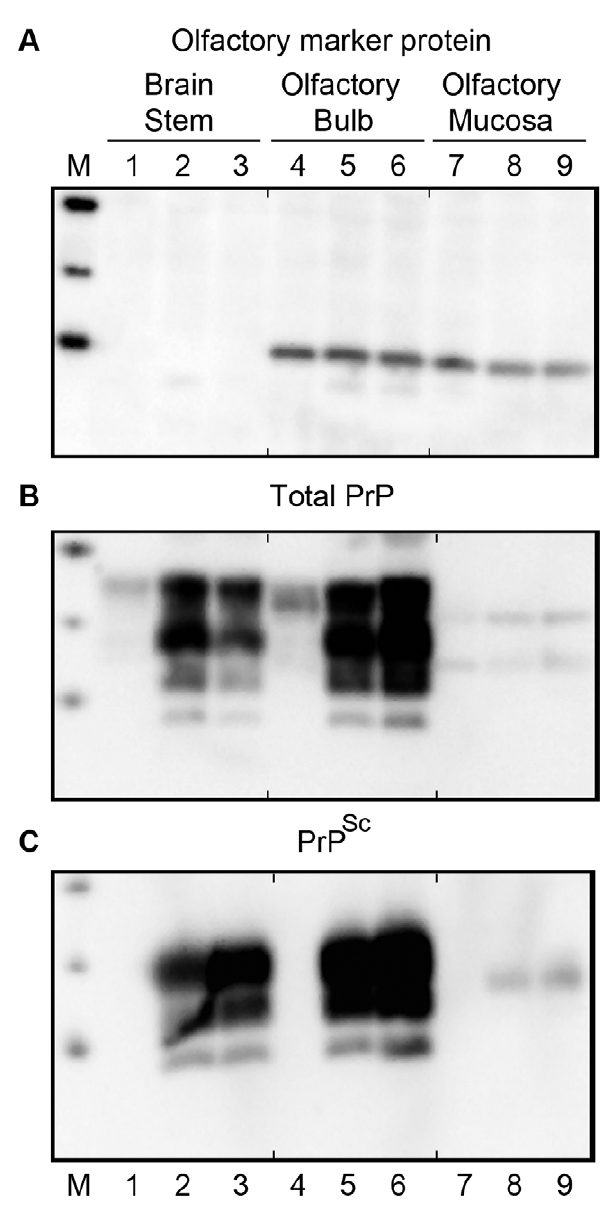
Figure 1. Western blot for olfactory marker protein and prion protein in brainstem, olfactory bulb, and olfactory mucosa following HY TME infection of hamsters. Tissue from age-matched, mock-infected (lanes 1, 4, 7) and HY TME-infected (lanes 2, 3, 5, 6, 8, 9) hamsters following intracerebral (lanes 2, 5, 8), and intra-olfactory bulb (lanes 1, 3, 4, 6, 7, 9) inoculation were homogenized and 50 ( A , B ) or 100 ( C ) micrograms of protein was analyzed per lane. In C , protein samples were digested with 10 ug/ml of proteinase K for 37 u C for 1 hour prior to SDS- PAGE. This treatment removes PrP C in mock-infected samples and truncates PrP Sc in HY TME lysates. Total prion (PrP) protein ( B ) and PrP Sc ( C ) was immunodetected with anti-PrP 3F4 monoclonal antibody, while olfactory marker protein ( A ) was immunodetected with polyclonal goat serum to OMP. OMP is present in both the olfactory bulb, which contains the olfactory nerve and terminals,andin the olfactory mucosathat contain the soma, dendrites, and axons of ORNs. Marker (M) polypeptides correspond to 20, 30, and 40 kDa. The short vertical tick marks at the top and bottom of each panel are placed before lanes 4 and 7 in order to align lanes between each panel.